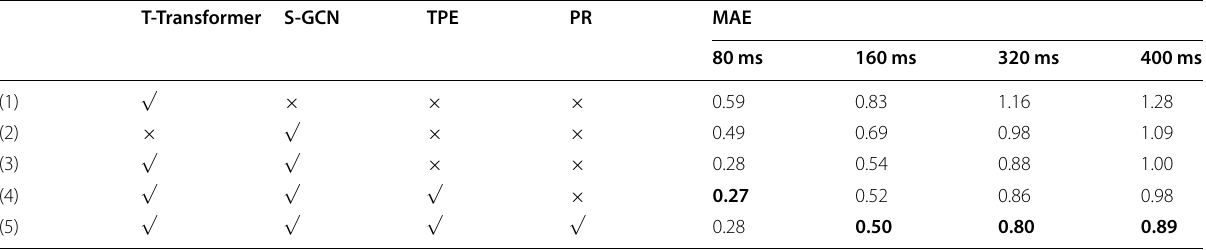
Table 2 The ablation studies of different modules in STTG-Net, reporting results for the joint angle errors on Human3.6M. “ √ ” indicates that the module is used in experiment, “ ” means that the part is removed from experiment ×